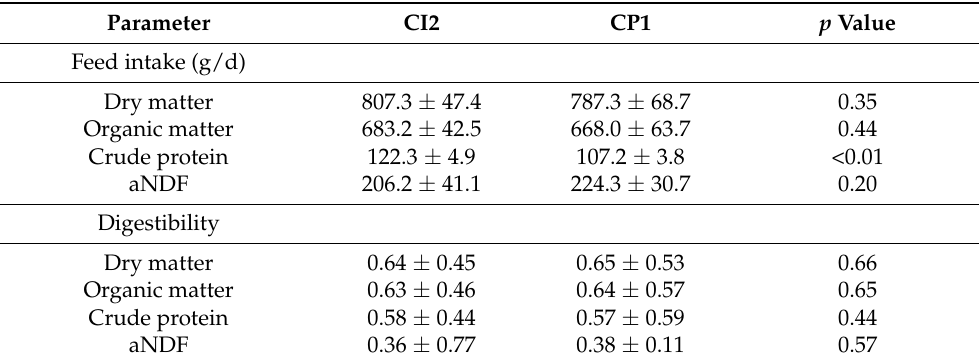
Table 4. Comparisons of feed intake and total track digestibility of lambs fed Coleus amboinicus Lour. ( n = 4, mean value).